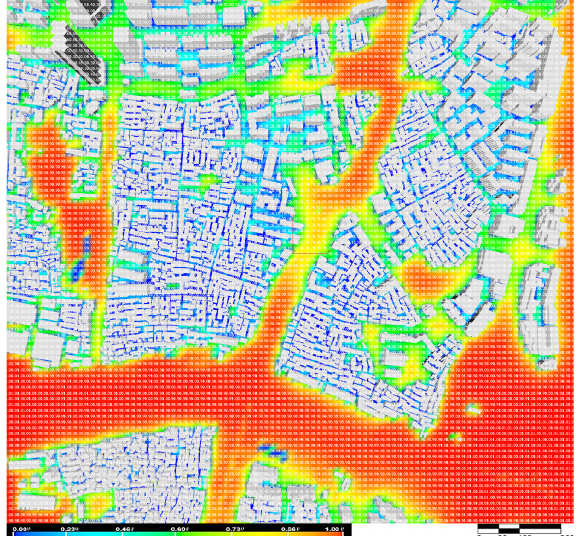
Figure 10. This figure shows Chengnan, an historical area of inner Nanjing, China, SVF calculated at 10m intervals.